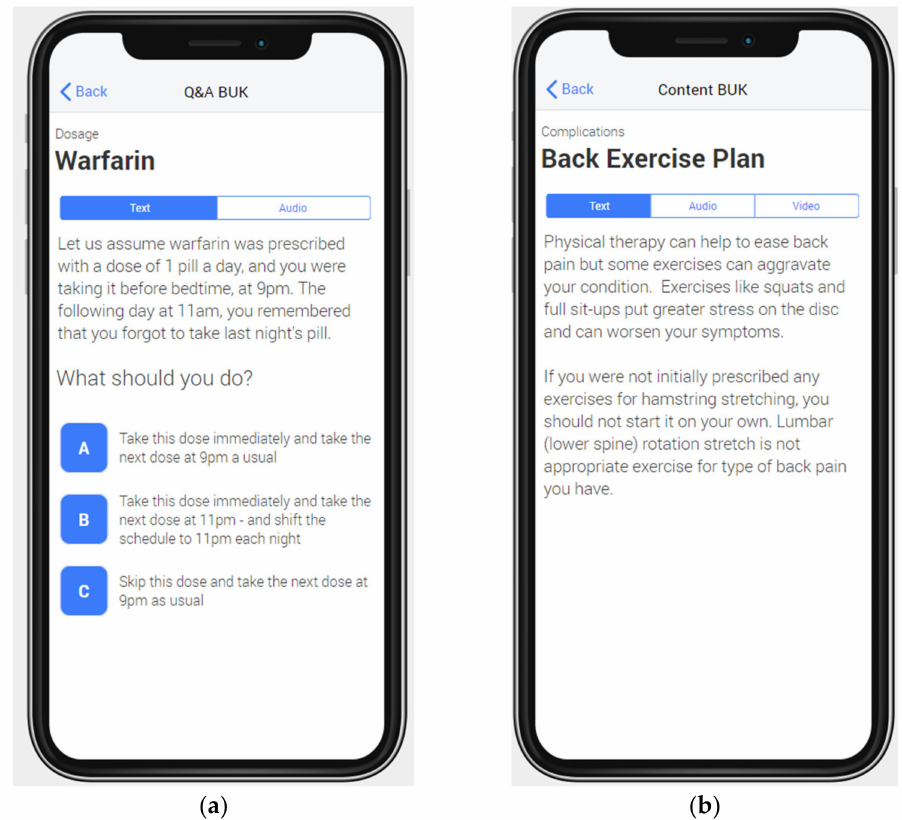
Figure 5. ( a ) A Q&A BUK related to missed anticoagulant dosage for higher-order learning cus- tomized for warfarin; ( b ) A Content BUK regarding back exercises for patients with a low basic level of comprehension and the Read/write VARK presentation